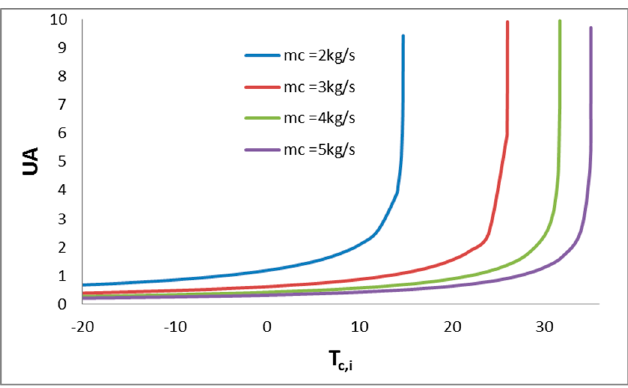
Figure 10. UA versus the inlet temperature of geothermal water.